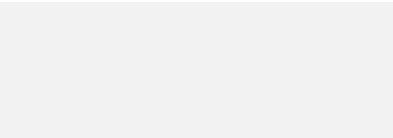
Figure 7 . The plane with a conformal boundary figure 6b can be further conformally mapped to an upper-half-plane (UHP) by eq. (4.9). The conformal boundary is mapped now to the real axis of the